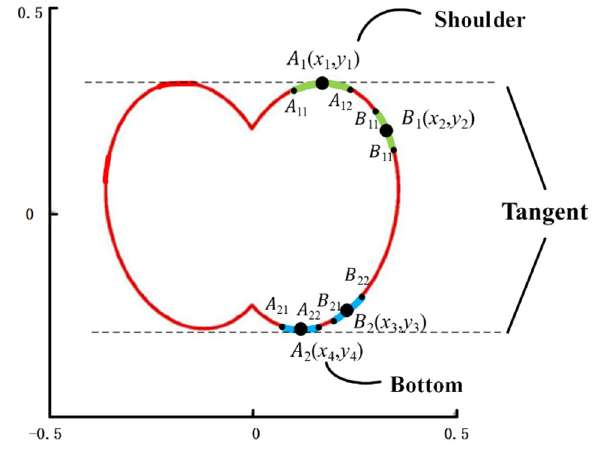
Figure 11. Apple shoulder and bottom schematic.